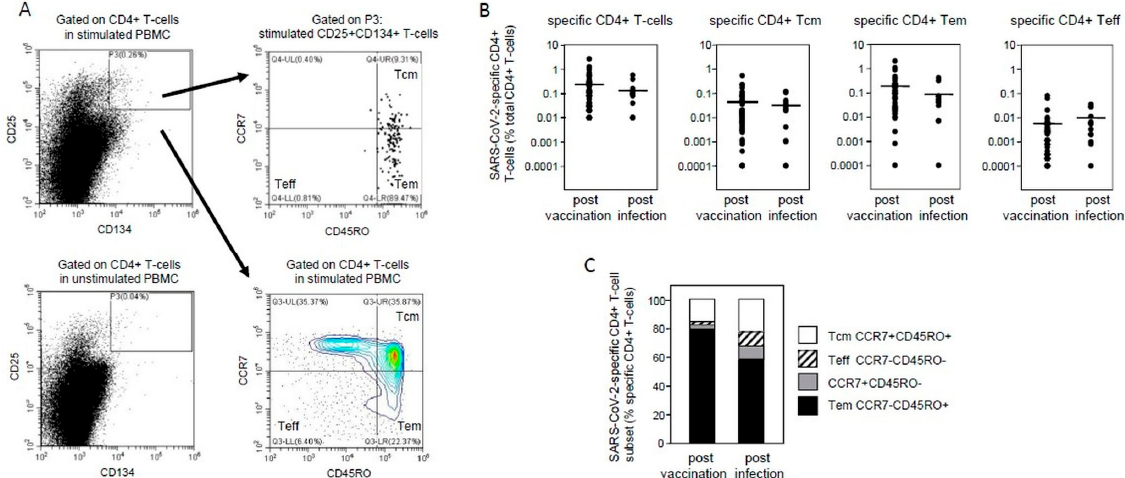
Figure 2. Comparison of SARS-CoV-2-specific memory CD4+ T-cell subsets following vaccination and infection. ( A ) Gating strategy: expression of CD25 and CD134 on CD4+ T-cells from stimulated (above left) or unstimulated (below left) PBMC from a representative vaccinated staff member. The percentages of SARS-CoV-2-specific CD4+ T-cells were calculated by subtracting the values of CD25 hi CD134 hi cells in gate P3 of stimulated PBMC from unstimulated PBMC. The whole CD4+ T-cell gate from stimulated PBMC was used set quadrants on T-cell subsets based on CCR7 and CD45RO expression (below right). Applying these quadrants to cells in the stimulated CD25 hi CD134 hi gate P3 allowed quantification of SARS-CoV-2-specific memory CD4+ T-cell subsets as percentage of specific CD4+ T-cells (above right). ( B ) Comparison of the frequencies of SARS-CoV-2-specific CD4+ T-cells, specific central memory CD4+ T-cells (Tcm), specific effector memory CD4+ T-cells (Tem), and specific effector T-cells (Teff) as a percentage of total CD4+ T-cells three months after vaccination and infection. Horizontal bars indicate mean values. ( C ) Comparison of the proportions of memory T-cell subsets as percentage of SARS-CoV-2-specific CD4+ T-cells at three months after vaccination and